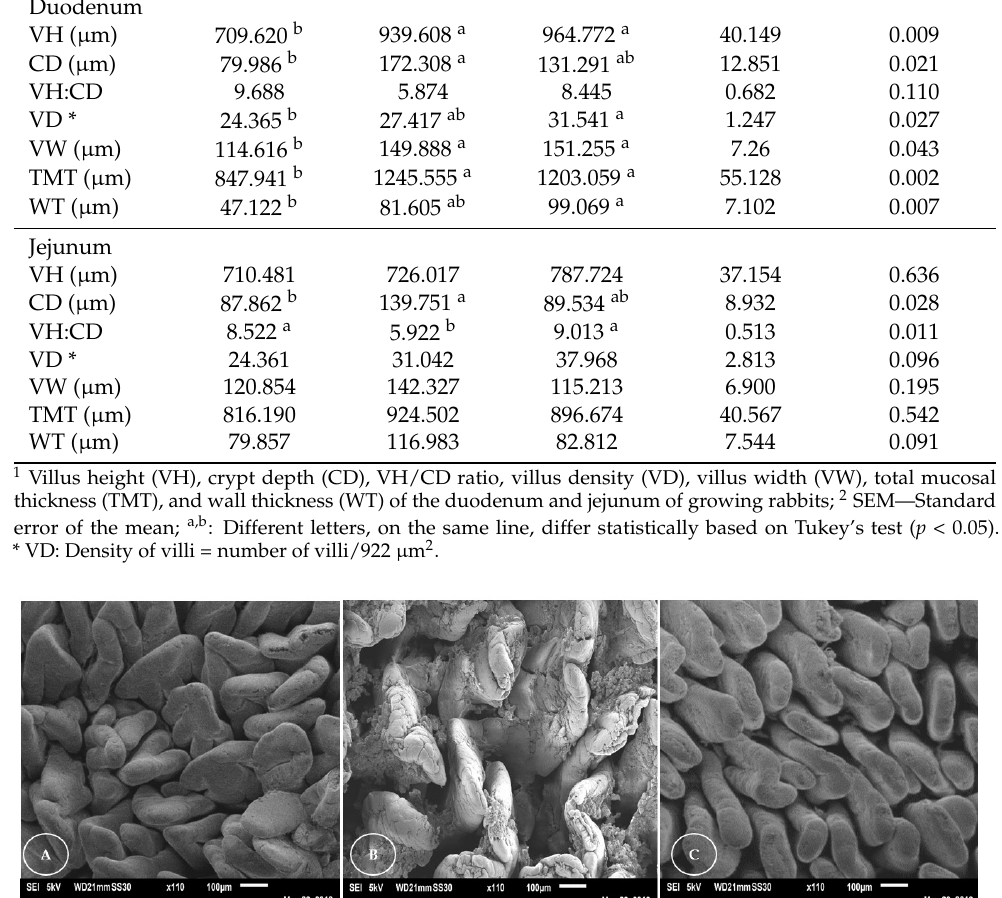
Table 5. Structural analysis and villi density of the intestinal epithelium of growing rabbits fed different sources of nanofibers and those fed a control diet.